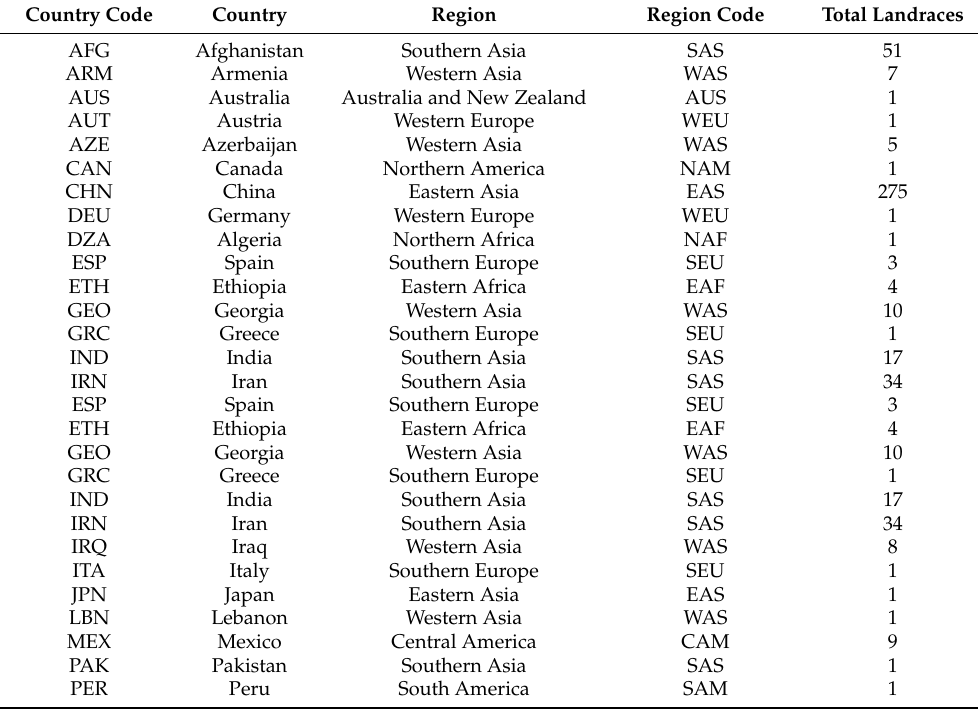
Table 6. Landrace countries of origin and geographic